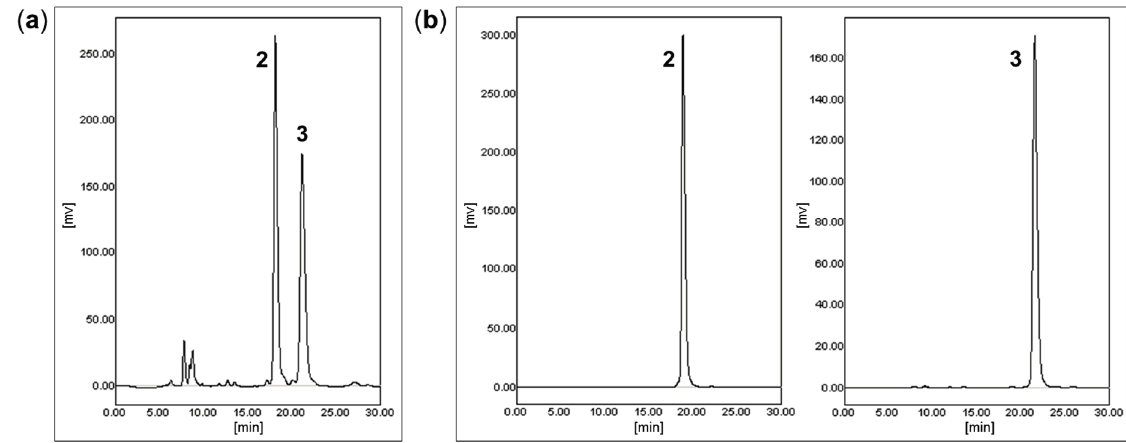
Figure 3. ( a ) HPLC chromatograms of mixture of 2 and 3 ; ( b ) HPLC